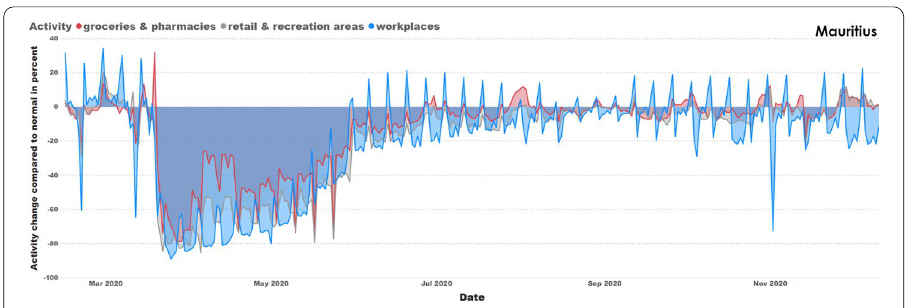
Fig. 21 Single intense lockdown